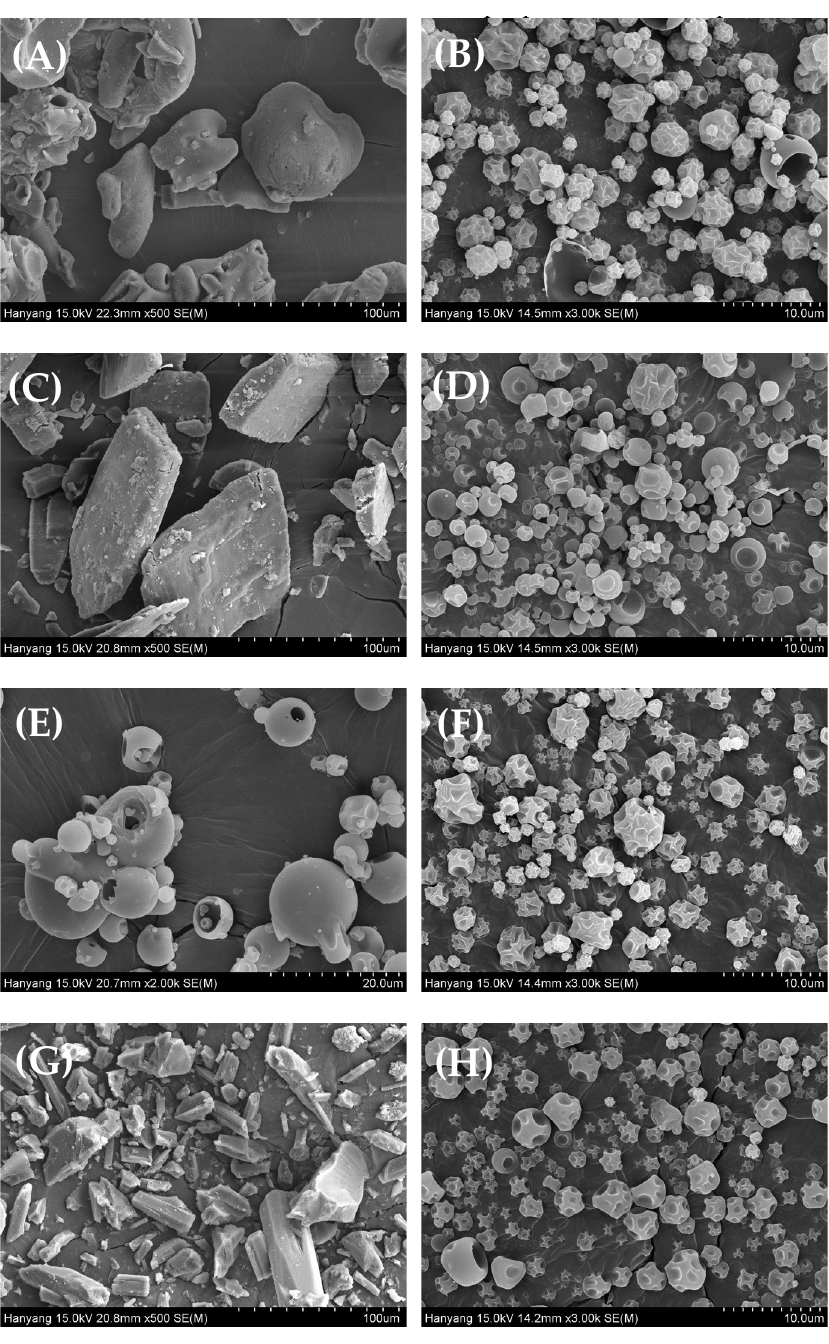
Figure 3. Scanning electron micrographs: ( A ) HP- β -CD (×300); ( B ) MTX/HP- β -CD inclusion complex (IC1) (×3000); ( C ) β -CD (×500); ( D ) MTX/ β -CD inclusion complex (IC2) (×2000); ( E ) Methyl- β -CD ( × 2000); ( F ) MTX/M- β -CD inclusion complex (IC3) ( × 2000); ( G ) Dimethyl- β -CD ( × 500); and ( H ) MTX/DM- β -CD inclusion complex IC4 ( ×